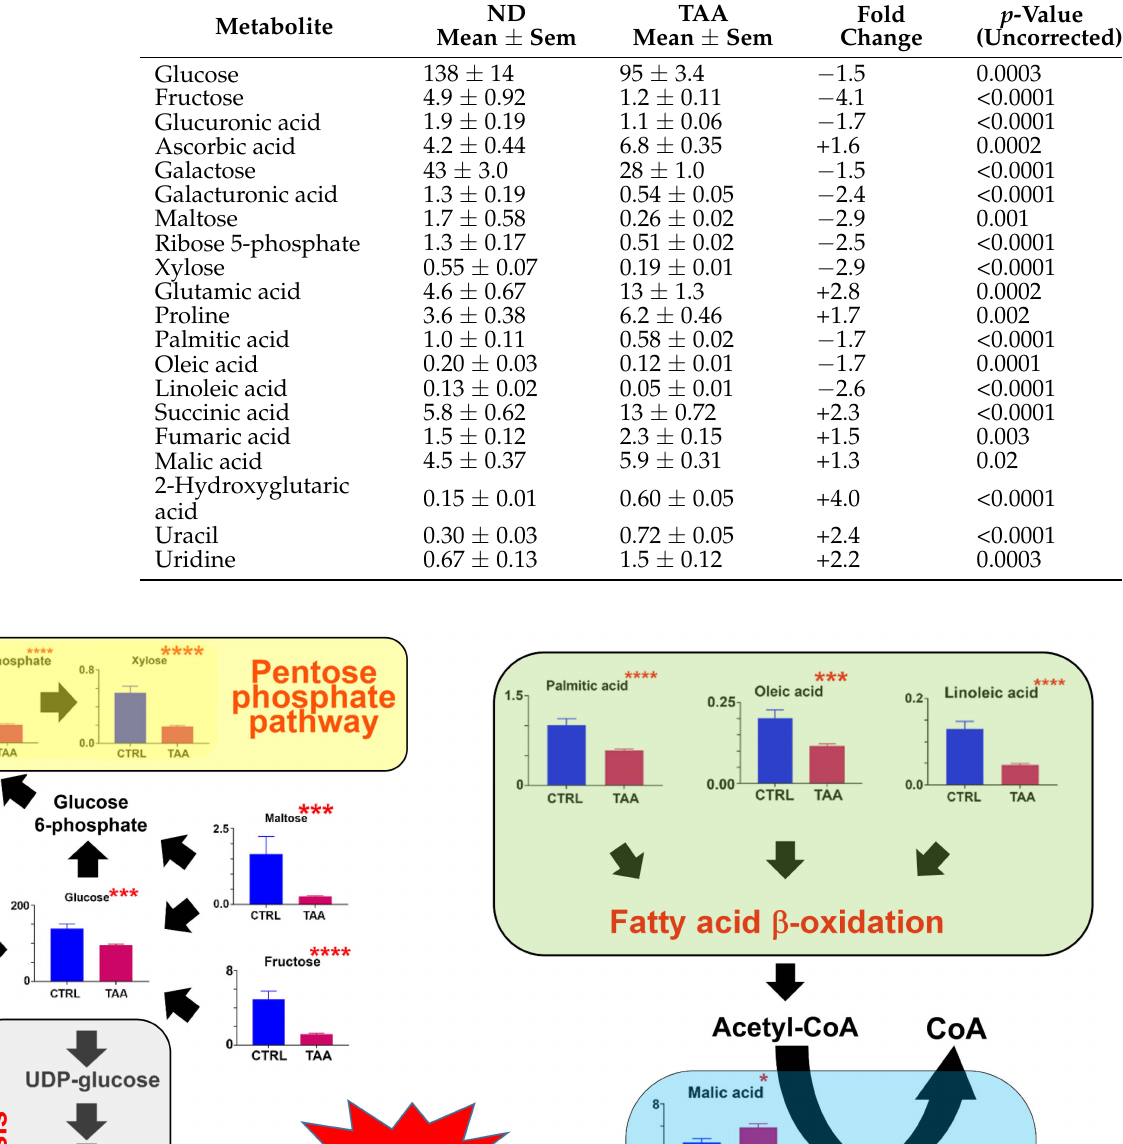
Table 2. Hepatic metabolite levels on a normal diet only (ND) and after administration of thioac- etamide (TAA).